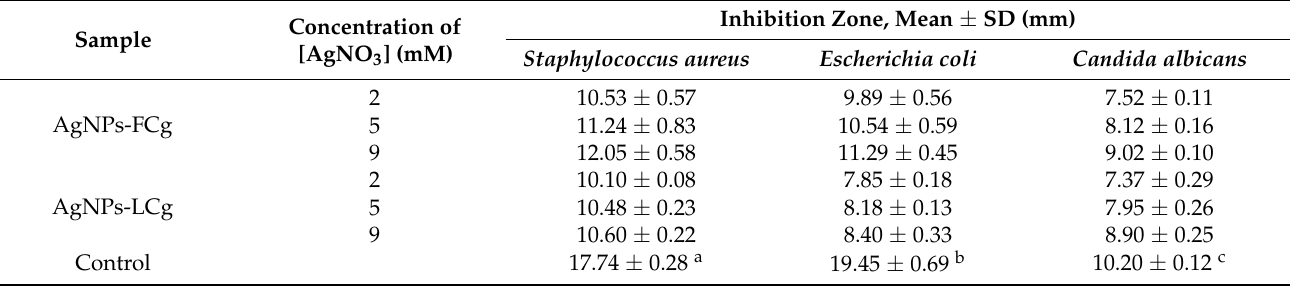
Figure 6. Antimicrobial activity analysis: ( A ) AgNPs-FCg; ( B ) AgNPs-LCg (I: E. coli bacteria, II: S. aureus bacteria, III: C. albicans fungus where a: negative control, b: positive control, c: sample with AgNO 3 concentration of 2 mM, d: sample with AgNO 3 concentration 5 mM, e: sample with 9 mM AgNO 3 concentration). Table 3. Antimicrobial activities of AgNPs-FCg and AgNPs-LCg. Table 3. Antimicrobial activities of AgNPs-FCg and